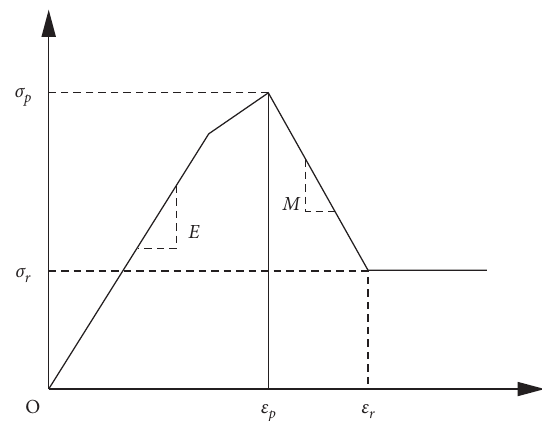
Figure 2: Scheme of representative simplified stress-strain curves [20].